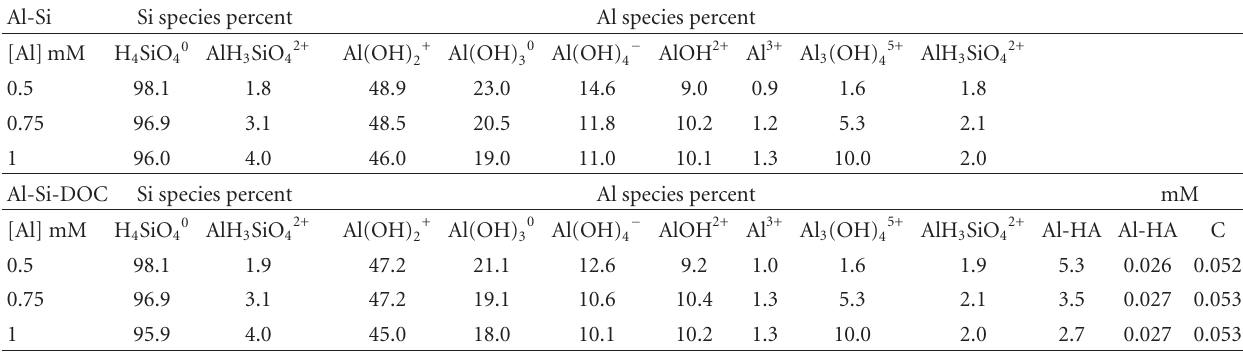
Table 2: Speciation of Al and Si in 0.5, 0.75, and 1.0 mM Al; 0.5 mM Si solutions with 0 (Al-Si) and 6mg/L (Al-Si-DOC) as calculated using Visual MINTEQ ver 2.53 with the Thermo.vdb database 1 .